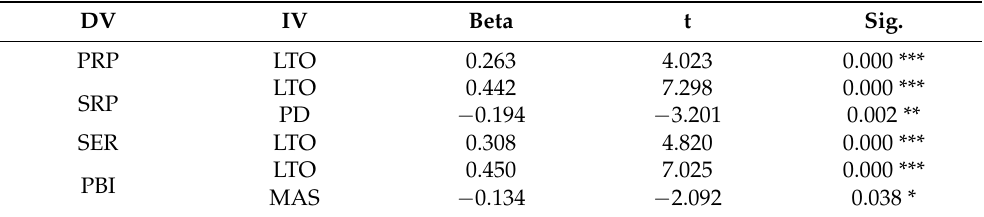
Table 9. The impact of cultural differences on health perception in